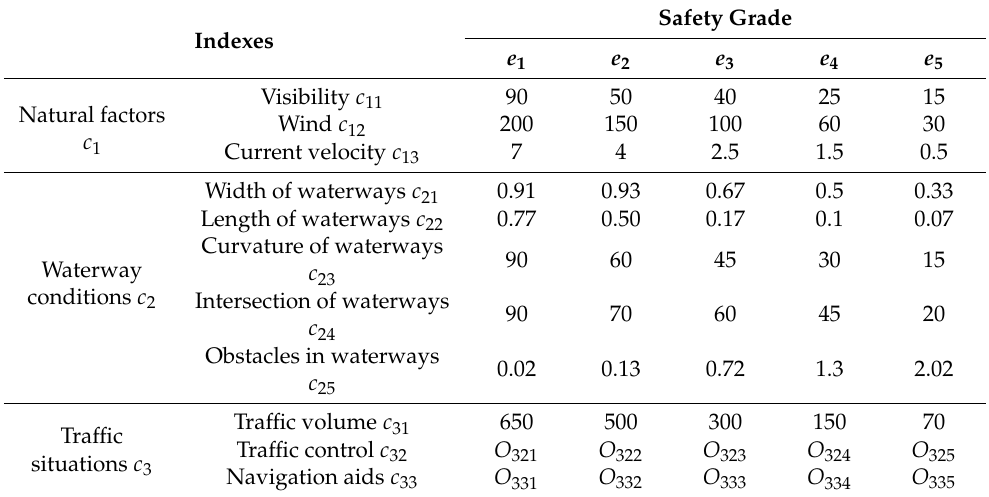
Table 1. The index system and categorisation criterion for assessing the safety grade of a waterway